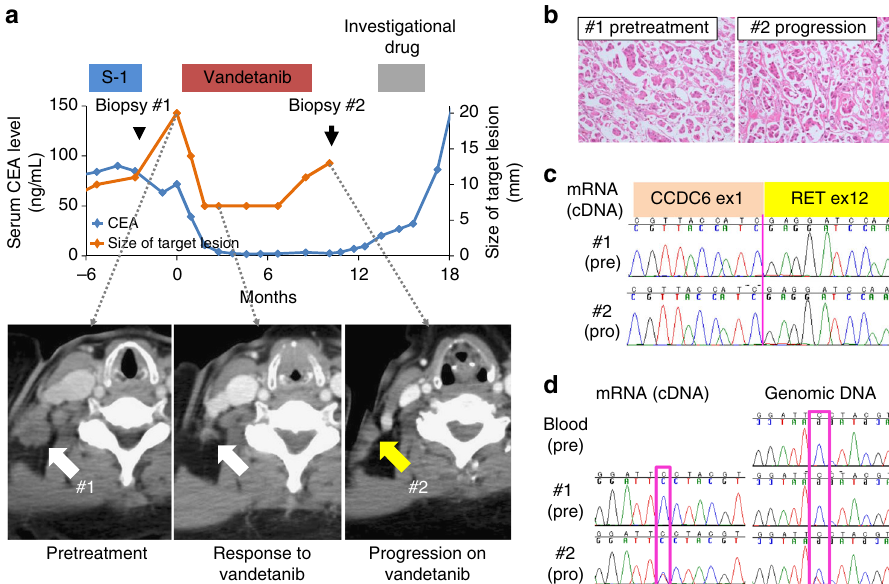
Fig. 1 Identi fi cation of a RET-S904F mutation conferring resistance to vandetanib. a Clinical course of the patient and axial chest computed tomographic (CT) scan. (Upper) The blue line indicates the serum CEA level, and the orange line indicates the size of the target lesion (the right metastatic cervical lymph node). The time points of the biopsy of metastatic lymph nodes are indicated by an arrowhead in Biopsy #1 and an arrow in Biopsy #2 (the details of the clinical course are shown in Supplementary Fig. 1). (Lower) CT scan images of the metastatic lymph node as a target lesion. b Sanger